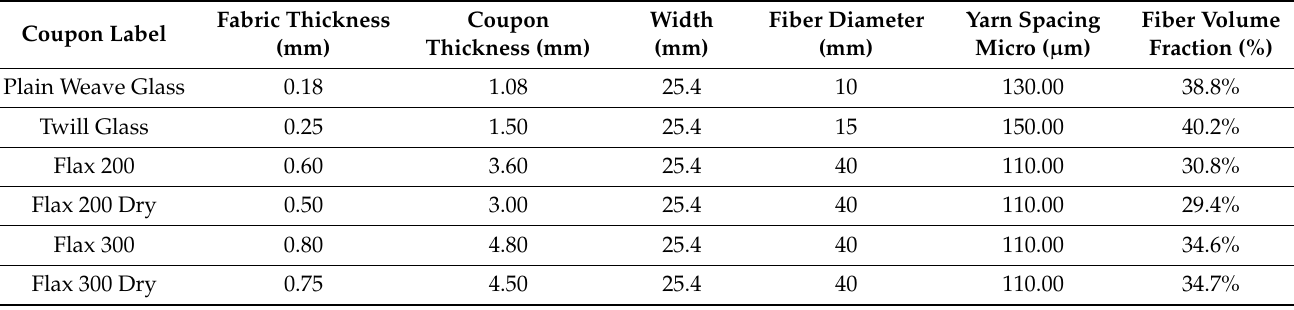
Table 1. Parameters used in the finite-element model .